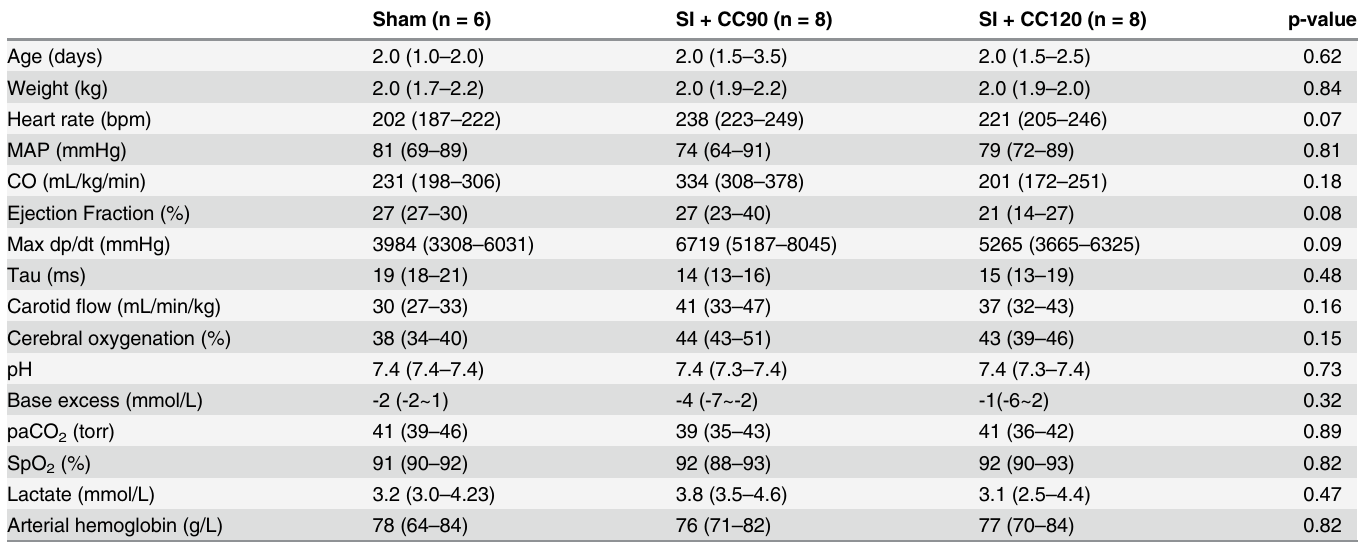
Table 1. Baseline